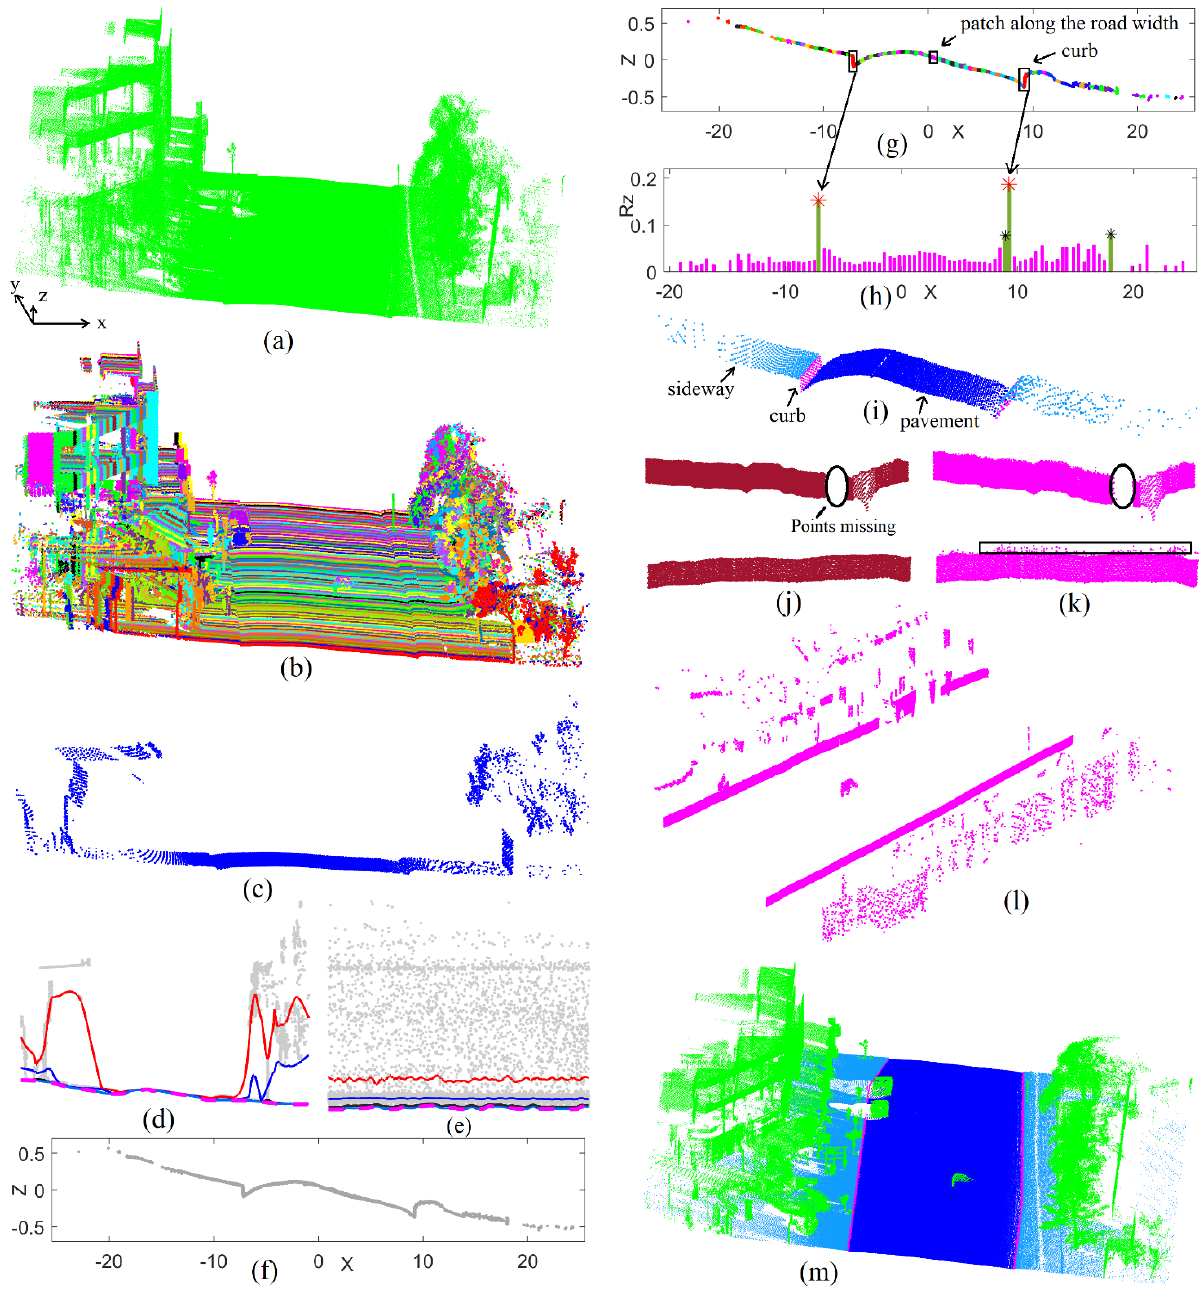
Figure 3. Road surface extraction, Experiment 1: (a) road point cloud, (b) different stripes in different colors, (c) one selected stripe along the road length, (d) iterative fitting for ground filtering using RLWR on the x - z profile, (e) iterative fitting for ground filtering using RLWR on the y - z profile , (f) filtered ground points for plot (c), (g) patches along the road width, (h) bar diagram for the 𝑅 𝑧 values for the patches of plot (g), (i) classified road surface points for plot (c), (j) ground truth curb surface, (k) curb extracted by the proposed method, (l) curb extracted by Zhao et al. (2021), and (m) classified road and non-ground surfaces for the full data